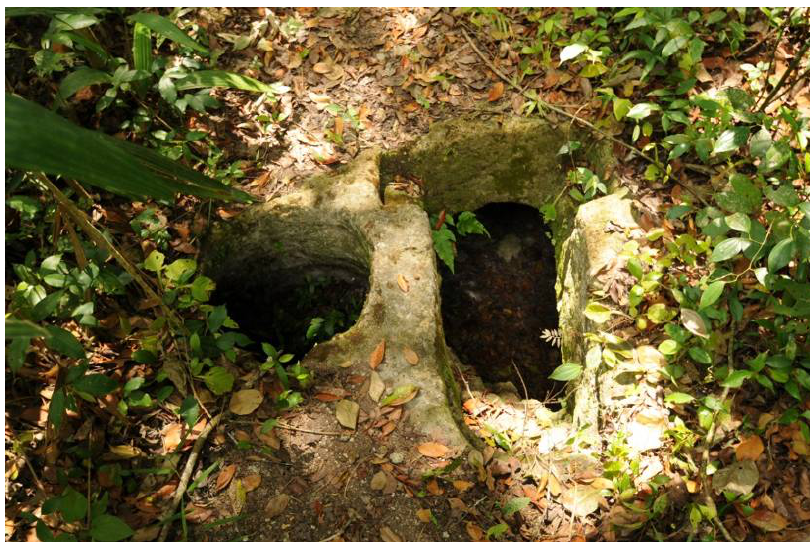
Figure 21. Entrance to Mayan chultan located in Tikal, Guatemala (photo copyright by L.W.